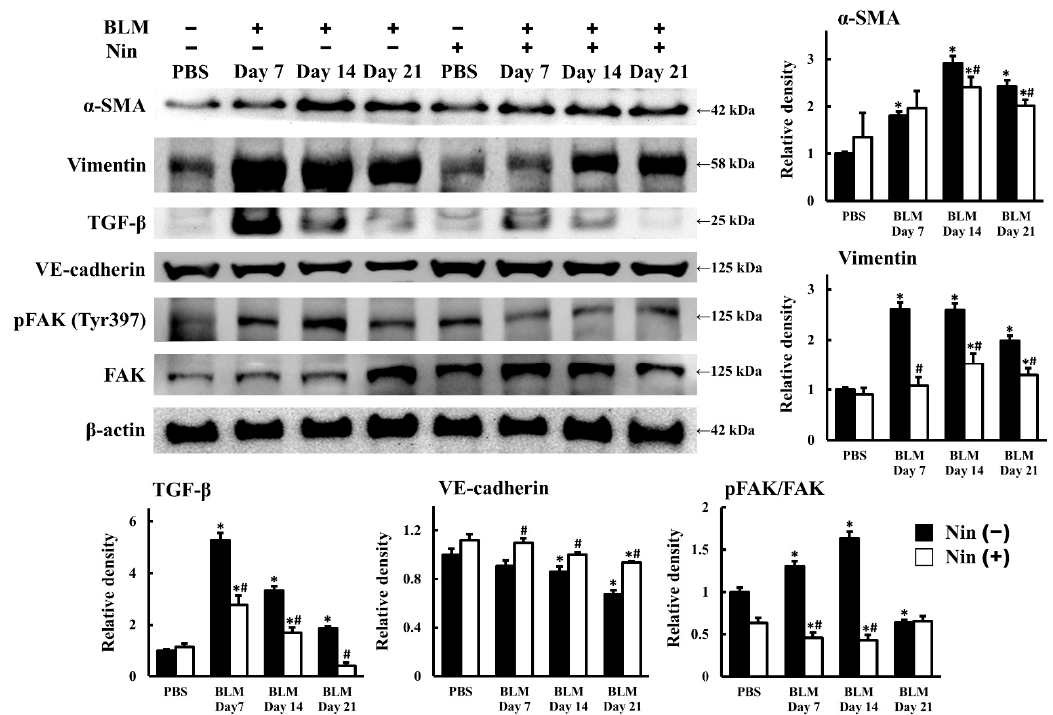
Figure 3. Nintedanib reverses BLM-induced changes in protein expression in murine lungs. West- ern blot and semi-quantitative analysis of protein expression in BLM-treated murine lung homoge- nates with or without nintedanib treatment. Western blot was performed using the indicated anti- bodies. n = 3–5 in each group. α -SMA, alpha smooth muscle actin; BLM, bleomycin; FAK, focal ad- hesion kinase; Nin, nintedanib; pFAK, phosphorylated focal adhesion kinase; TGF- β , transforming growth factor beta; VE-cadherin, vascular endothelial cadherin. Data are presented as mean ± stand- ard error of mean. * p < 0.05 vs. PBS, and # p < 0.05 vs. BLM (two-tailed Student’s t-test).